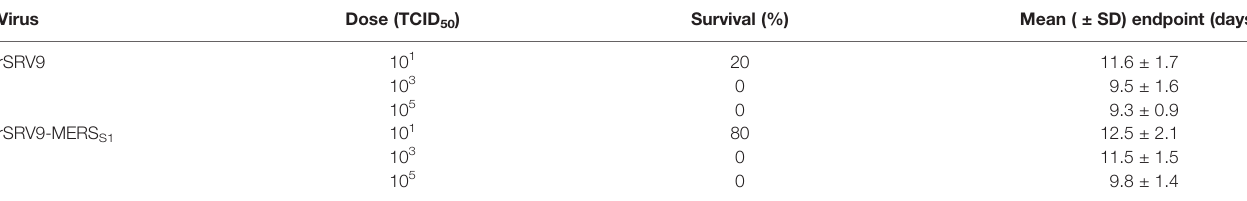
TABLE 1 | The neurovirulence of rSRV9-MERS S1 compared to rSRV9 in 5-day-old suckling mice.